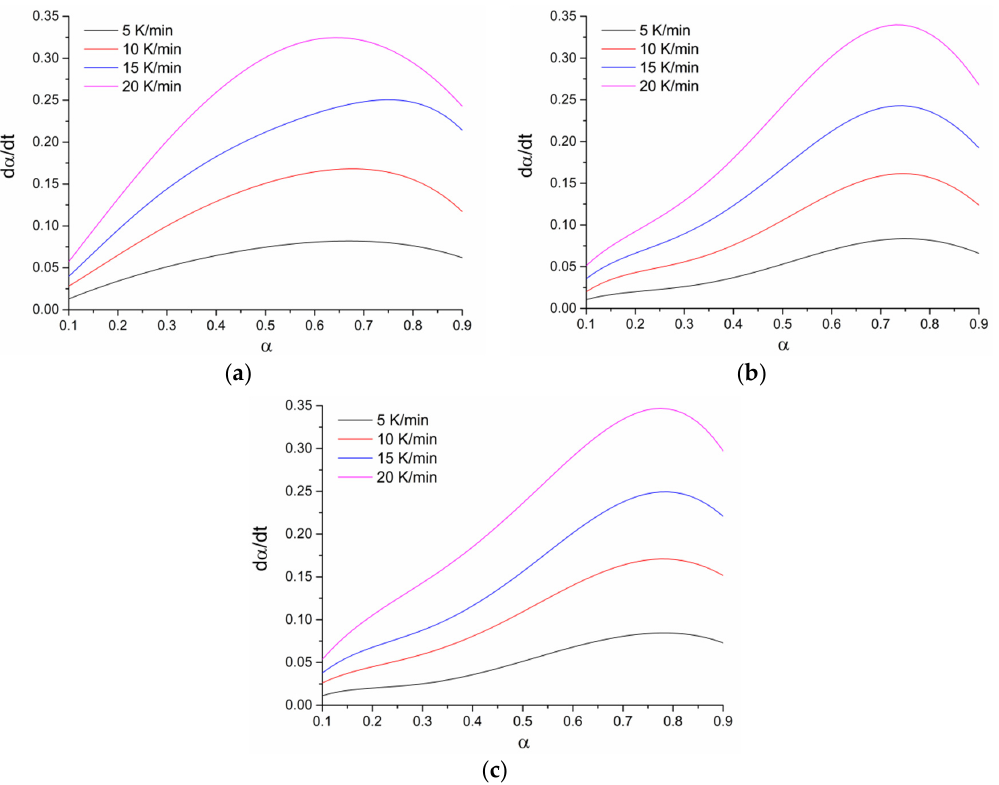
Figure 6. Dependence of (d α /d t ) on oligomers conversion (0.1–0.9): ZnO ( a ), γ -Al 2 O 3 ( b ), without